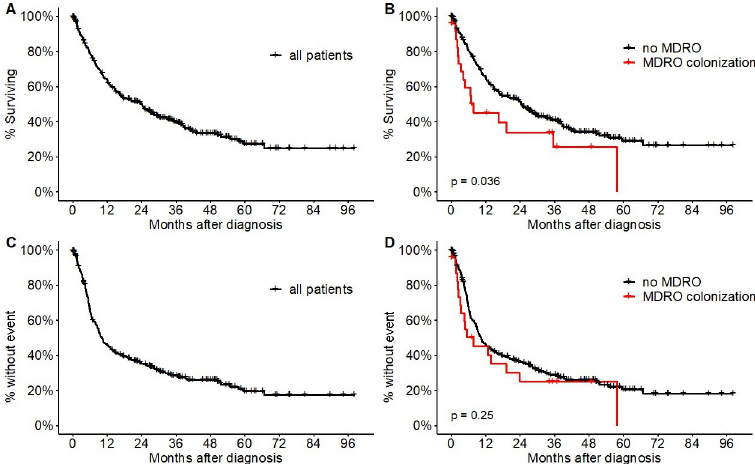
Fig 1. Kaplan-Meier estimates of overall survival (OS) and progression-free survival (PFS). (A) OS of all patients. (B) OS of patients stratified by multidrug-resistant organism (MDRO) colonization. (C) PFS of all patients. (D) PFS of patients stratified by colonization with MDRO. Log-rank test was used to calculate p values in (C+D).